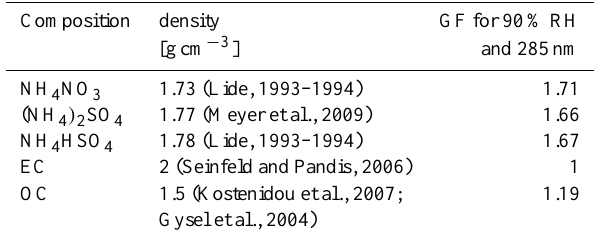
Table 1. Overview of the density values and growth factors of the pure